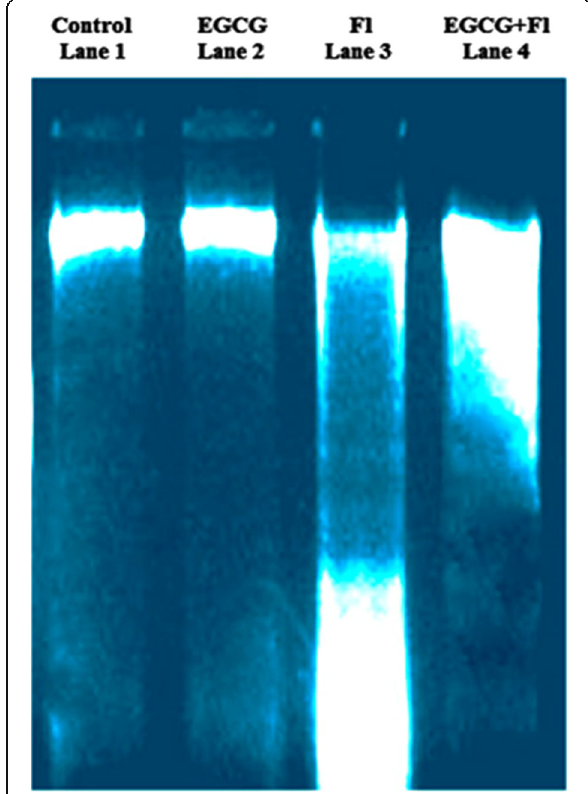
Fig. 12 Effect of EGCG on DNA fragmentation in the brain hippocampus of control and Fl-induced rats. Lane 1. Control (Normal DNA), Lane 2. EGCG (40 mg/kg BW) (Normal DNA), Lane 3. Fl (25 mg/kg BW) (increased DNA damage), Lane 4. EGCG + Fl (40 mg/kg BW) + Fl (25 mg/kg BW) (mild DNA